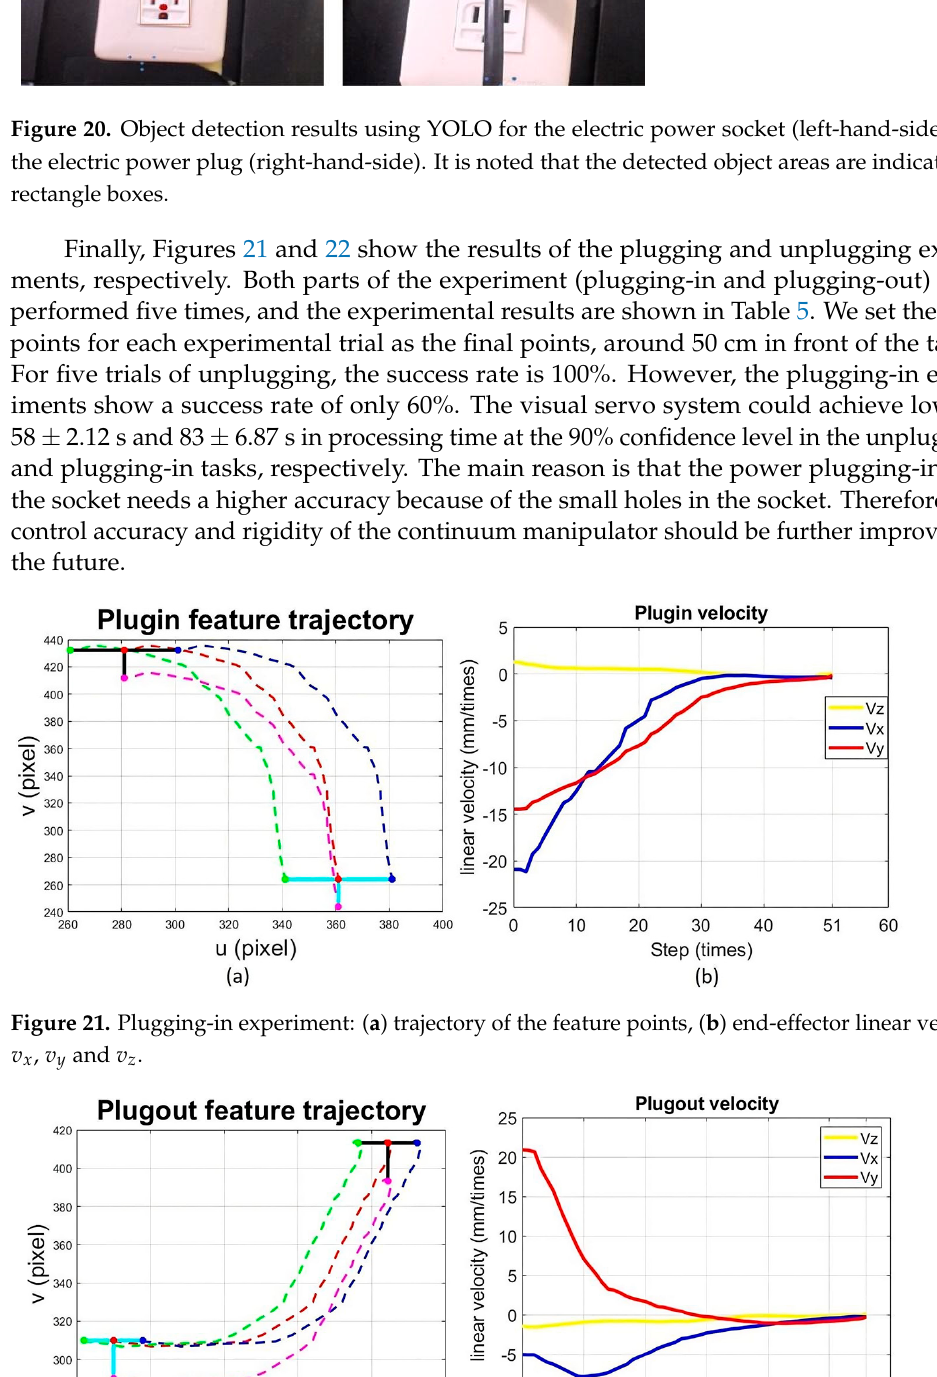
Figure 19. Specifications of the socket and plug. Figure 20. Object detection results using YOLO for the electric power socket (left-hand-side) and the electric power plug (right-hand-side). It is noted that the detected object areas are indicated as rec- tangle boxes.